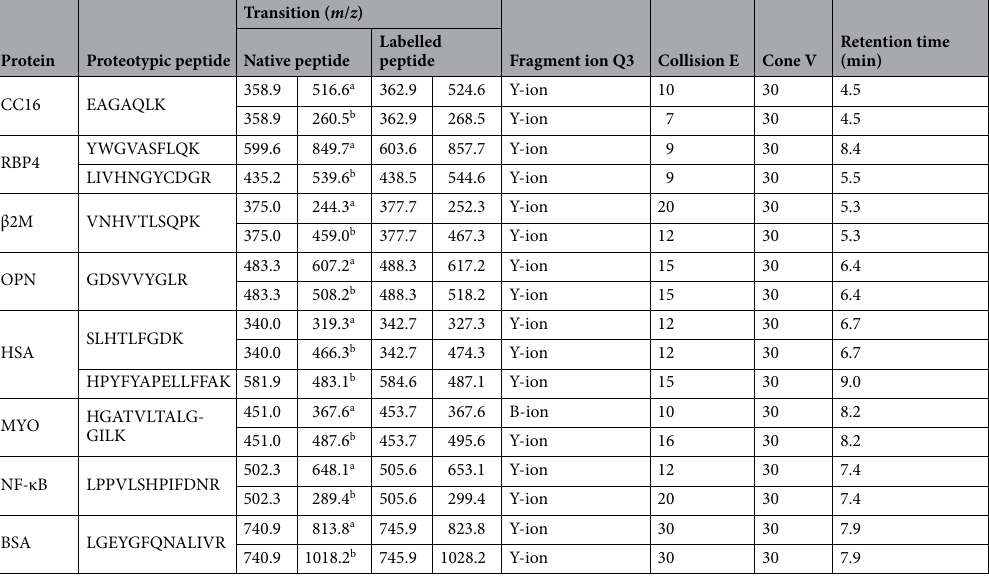
Table 1. Selection of proteotypic peptides used for relative quantification by MRM analysis. a Selected for method validation and relative quantification b Selected for confirmation of result; m / z : mass-to-charge ratio; E energy; V voltage.